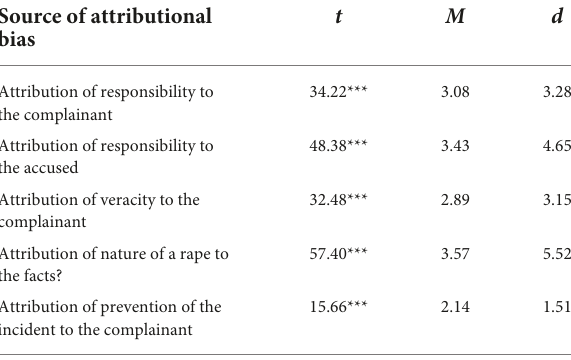
TABLE 4 One sample t -test of the attributional bias measures with a trivial attribution as test value (1, slightly). Source of attributional bias